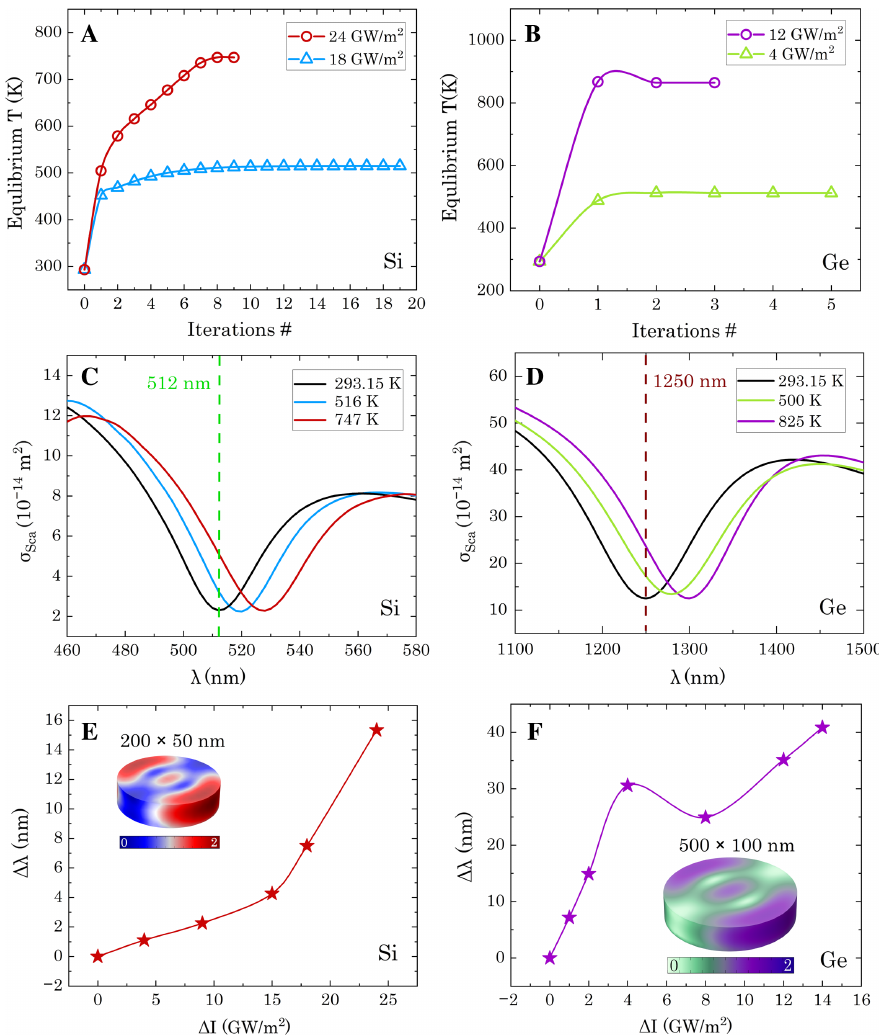
Figure 6: Self-induced optical heating of Si and Ge nanodisks supporting anapole modes. (A, B) Evolution of the average temperature of the nanodisks as a function of the iteration until equilibrium, for different illumination intensities; (C, D) scattering cross-section spectrum of the Si and Ge nanodisks exhibiting an anapole dip. Black curves are the room temperature spectra, whereas the colored curves represent the shift of the anapole mode due to self-induced optical heating, resulting in the indicated equilibrium temperature. The used illumination is shown in (A) and (B). The green and red vertical lines indicate the respective excitation wavelengths. (E, F) Spectral shift of the anapole mode as a function of the illumination intensity. The respective illumination wavelengths are shown in (C) and (D). Complex nonlinear behaviors are observed for self-induced optical heating of these